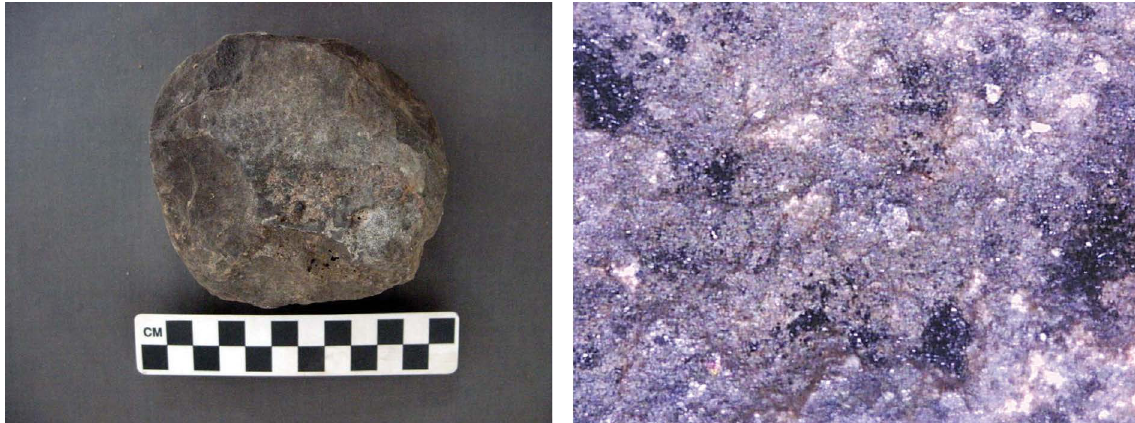
Figure 13. Dimpled hammerstone from Khirbat en-Nahas; andesite rock. Photomicrograph (right) of centre of ‘dimple’ shows crushed rock grains, pits, loose rock particles, and ‘frosted’ appearance. Image width = 2 mm.